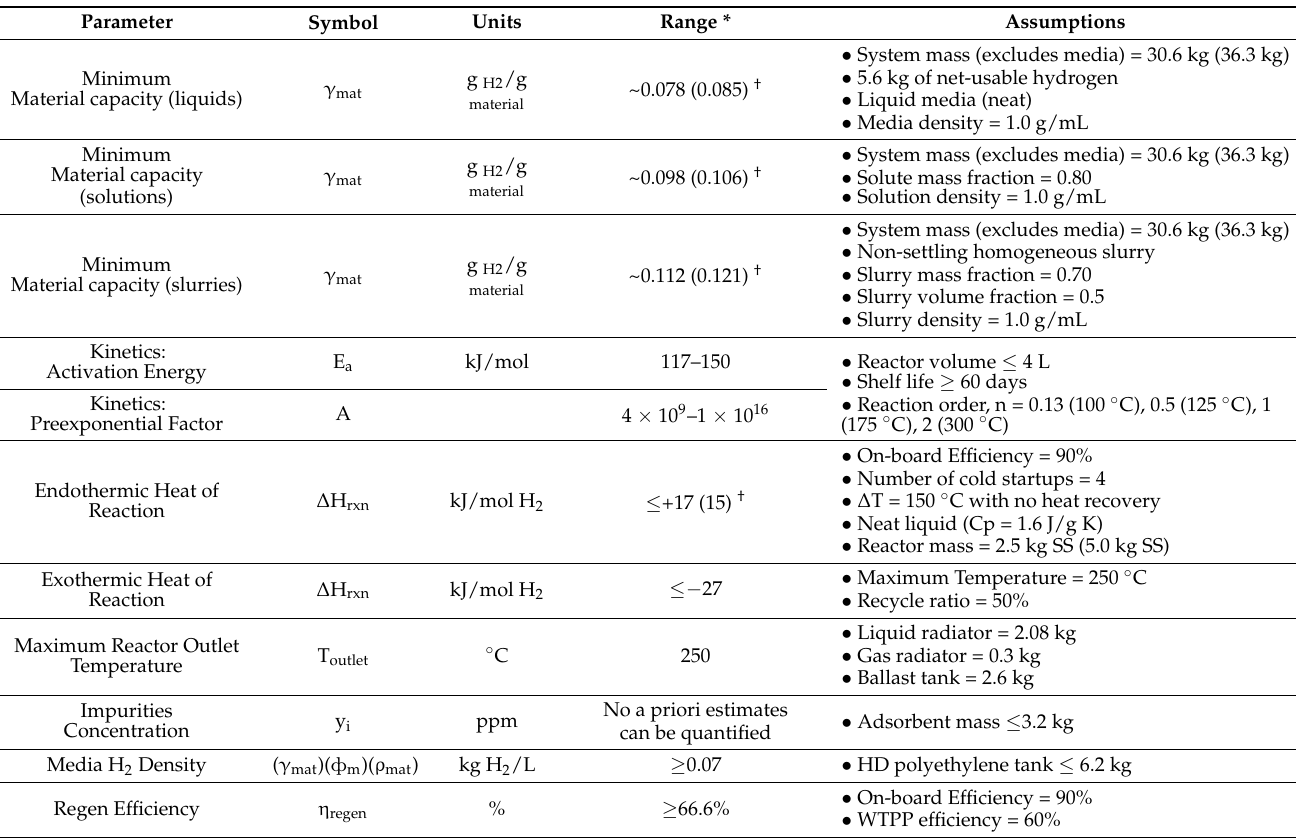
Table 6. Summary of chemical hydrogen material properties required to meet the 2017 DOE Targets for Onboard Hydrogen Storage Systems for Light Duty Vehicles